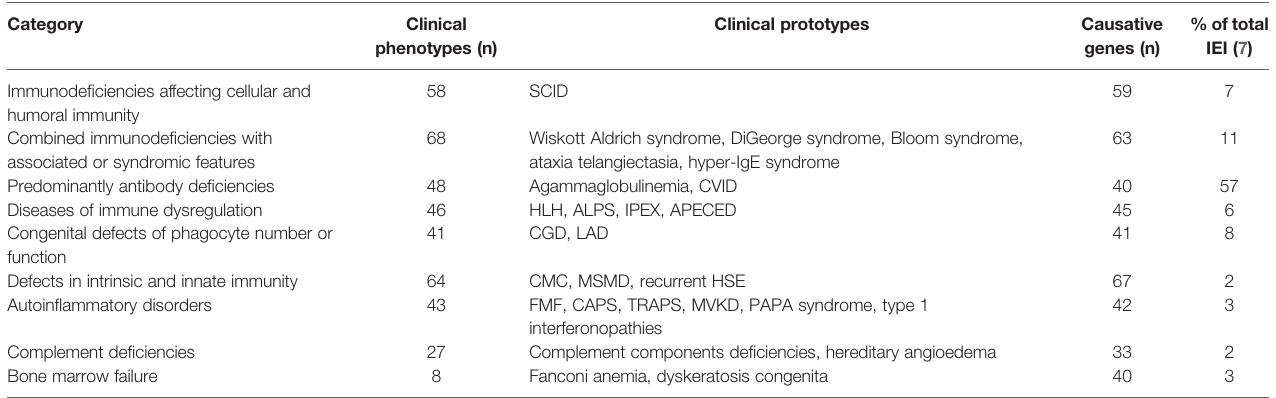
TABLE 1 | IEI categories and clinical prototypes according to the 2019 IUIS update of the phenotypical classi fi cation